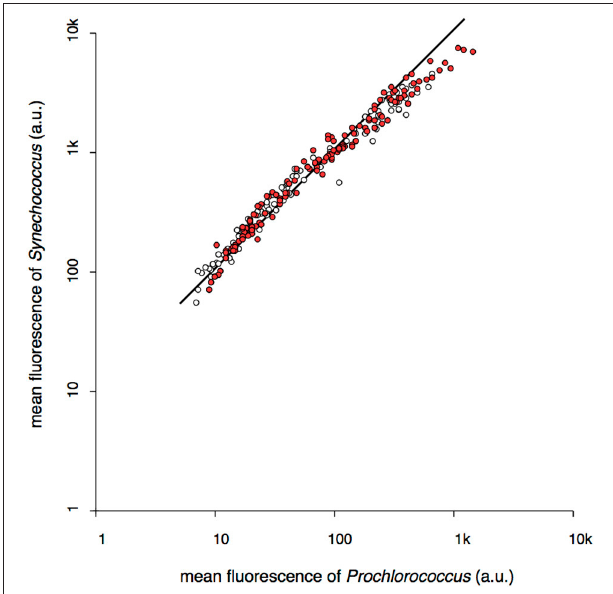
FIGURE 10 | The relationship between the average red fluorescence (chlorophyll) of Prochlorococcus and Synechococcus populations at each depth collected over the 2-week cruise period in March 2014 during which a significant wind-drive mixing event occurred. Open circles represent samples collected before, red circles indicate samples collected after peak wind